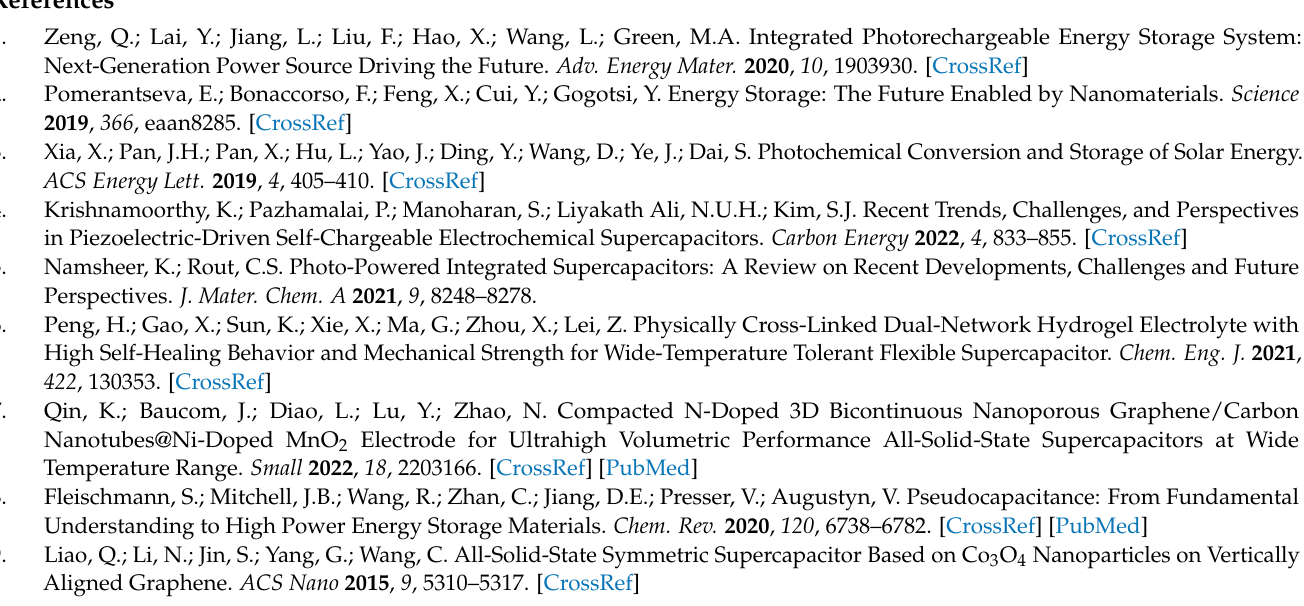
trodes.; Figure S3: Electrochemical properties of the AC electrodes: (a) the CV curves at various scan rates, (b) the GCD curves at various current densities, (c) Nyquist plot, (d) the specific capacitances at different current densities, (e) the specific capacitances at different current densities, and (f) the cycling performance at 5 A g − 1 ; Figure S4: CV curves at various scan rates: (a) CoO x -110//AC HSC, (b) CoO x -120//AC HSC, and (c) CoO x -140//AC HSC; GCD curves at various current densities: (d) CoO x -110//AC HSC, (e) CoO x -120//AC HSC, and (f) CoO x -140//AC HSC; Table S1: The quan- titative analysis of CoO x nanowire; Table S2: The electrochemical capability of CoO x -130//AC in comparison to CoO x -based materials previously